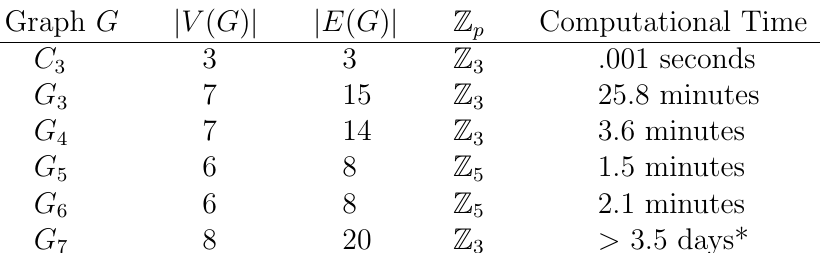
-magic labeling of G 5